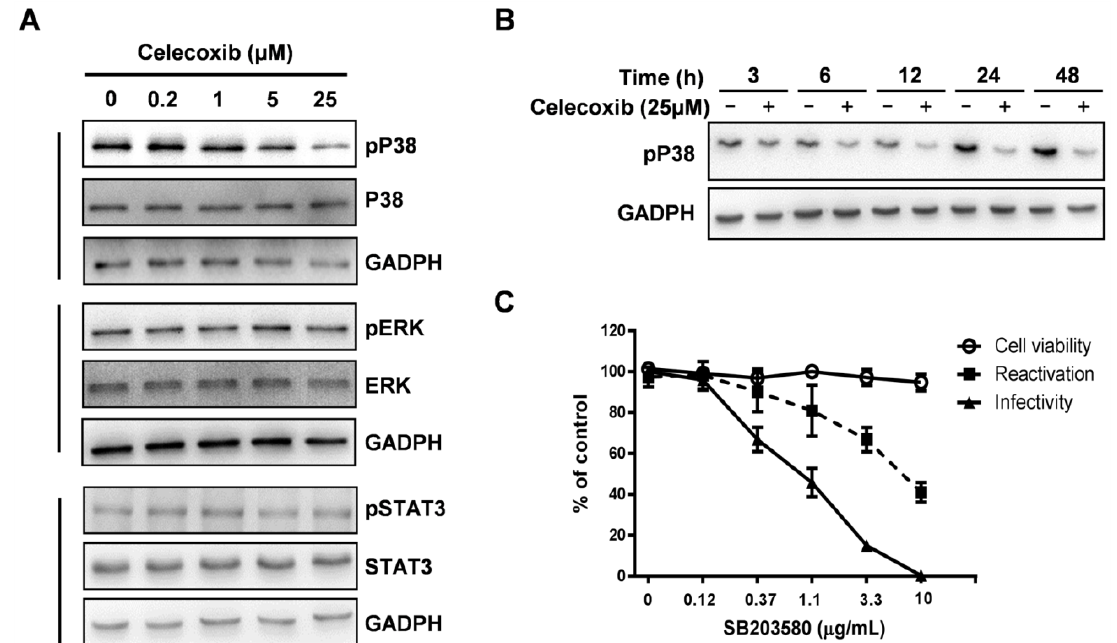
Figure 6. Celecoxib inhibits the activity of the p38 MAPK pathway. ( A ) The effect of celecoxib on test proteins in BCBL-1 was determined at 24 h following TPA induction by WB with specific antibodies; ( B ) Time course analysis of the phosphorylation of p38. BCBL-1 cells treated with celecoxib (25 µM) were collected at the indicated time points after TPA incubation and the phosphorylated form of p38 was detected by WB using a specific antibody. An anti-GADPH antibody was used to normalize the sample loading; ( C ) iSLK.219 cells were treated with SB203580 in the present of Dox and NaB for 48 h. The cytotoxicity of iSLK.219 was measured as described in Methods (○). Then RFP expression (■) in iSLK.219 and the virion infectivity of the supernatant (▲) to 293T was detected and analyzed using the HCS system. Data were normalized as the relative activity compared to the untreated control. The results are presented as mean values with standard deviations ( n =